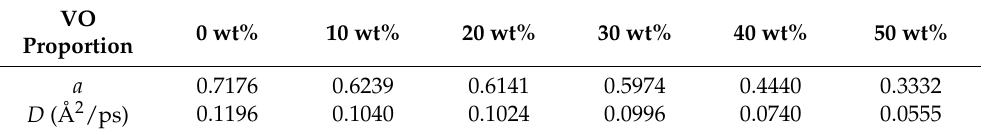
Table 2. The slope of the fitting line of MSD curve and the diffusion coefficient of water molecules in each mixed oil model with 1 wt% of water content.